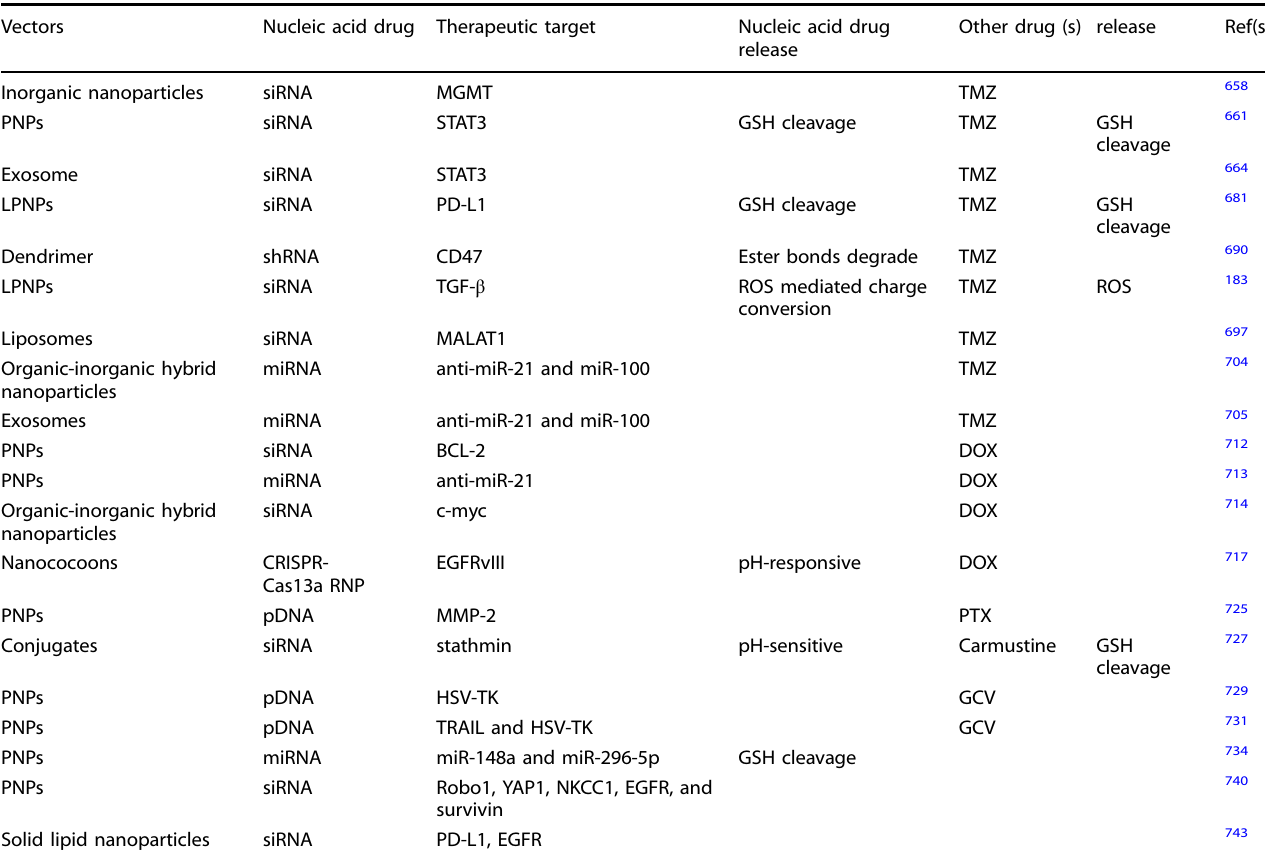
Table 5. Multi-drugs containing nucleic acid drugs synergistically loaded nanoparticles for brain tumor therapy